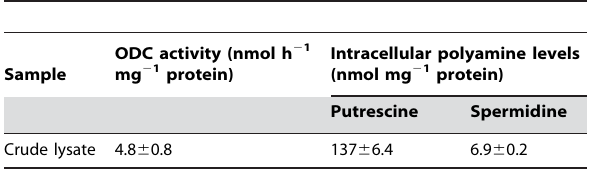
Table 1. Analysis of ODC activity and polyamine levels of E.